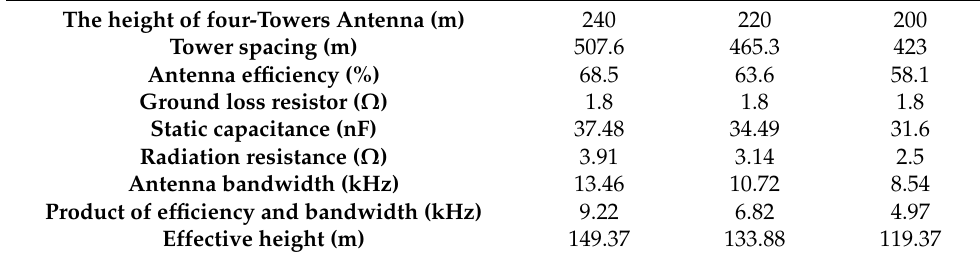
Table 2. Main Performance Parameters of the four-tower Antenna.